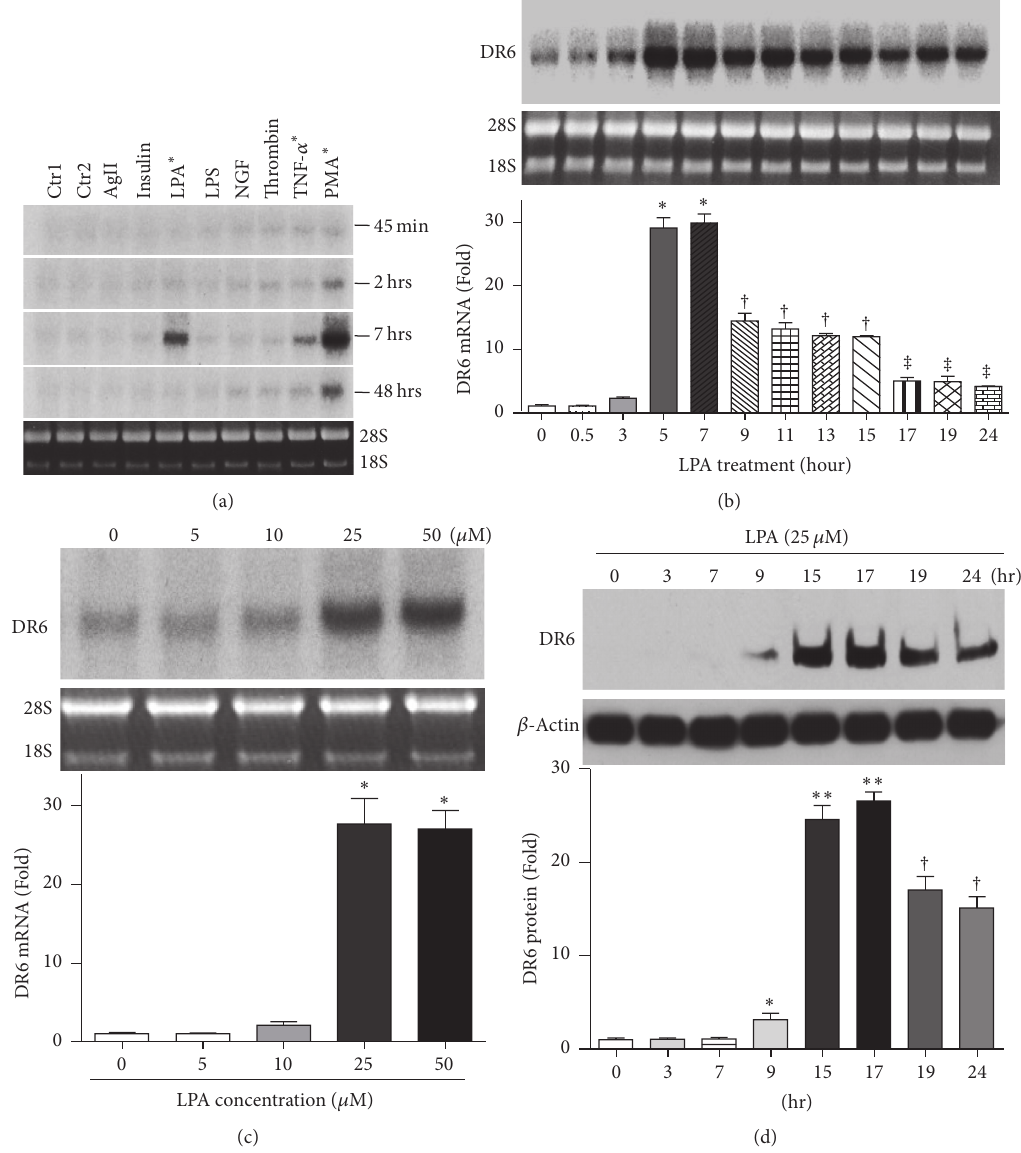
Figure 2: LPA upregulates DR6 expression in does- and time-dependent manner. (a) HeLa cells were exposed to various stimuli and the expression of DR6 was measured by Northern blot at different time points as indicated. Control 1: untreatment; Control 2: vehicle (DMSO) treatment. ∗ 𝑃 < 0.001 versus control. (b) HeLa cells were treated with LPA (25 𝜇 M) for different times as indicated. Expression of DR6 was measured by Northern blot. 𝑛 = 3 . ∗ 𝑃 < 0.001 versus control; † 𝑃 < 0.05 versus 5–7 hr time point, ‡ 𝑃 < 0.05 versus 9–15hr time points. (c) HeLa cells were treated with various concentrations of LPA for 16hrs. DR6 mRNA expression was measured by Northern blot. 𝑛 = 3 , ∗ 𝑃 < 0.001 versus control. (d) HeLa cells were treated with LPA 25 𝜇 M for the times indicated. The cells were then lysed, and 50 𝜇 g of the cell lysates was analyzed by SDS-PAGE followed by Western blotting with anti-DR6 antibody and then were visualized by the enzyme-linked chemiluminescence system. The bar graphs below are densitometry analyses of DR6 protein expression. Data presented are mean ± SD from 3 independent experiments, with untreated controls set as 1. ∗ 𝑃 < 0.05 , ∗∗ 𝑃 < 0.001 versus control; † 𝑃 < 0.05 versus 15–17 time